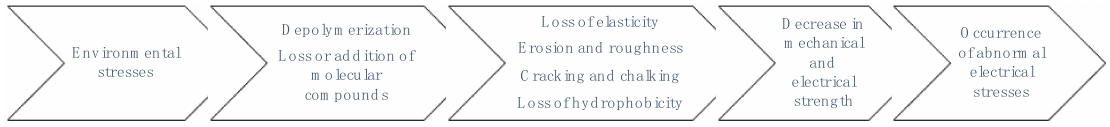
Figure 1. The steps that lead to faults related to the electrical stresses of HV insulators.